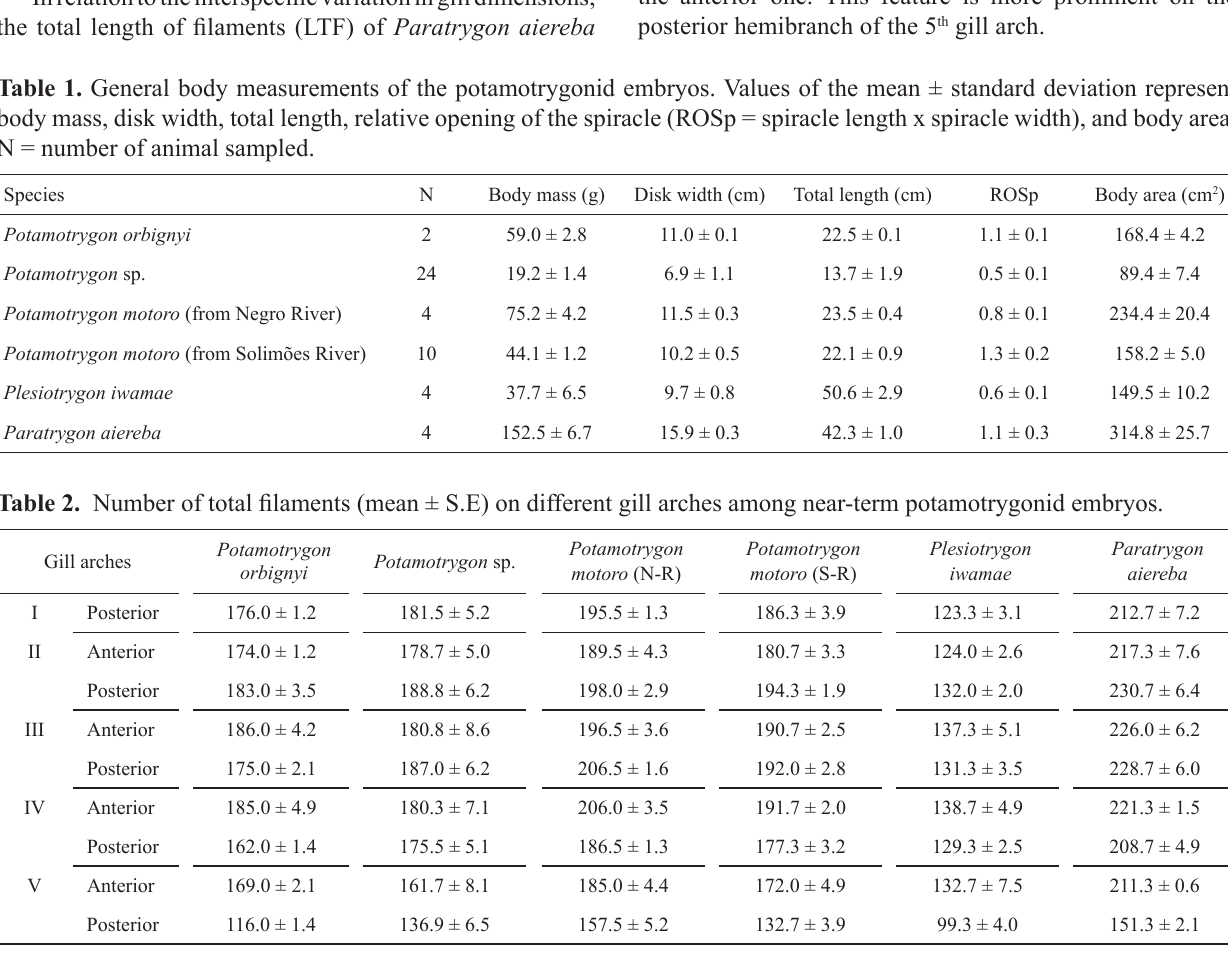
Table 1. General body measurements of the potamotrygonid embryos. Values of the mean ± standard deviation represent body mass, disk width, total length, relative opening of the spiracle (ROSp = spiracle length x spiracle width), and body area. N = number of animal sampled.